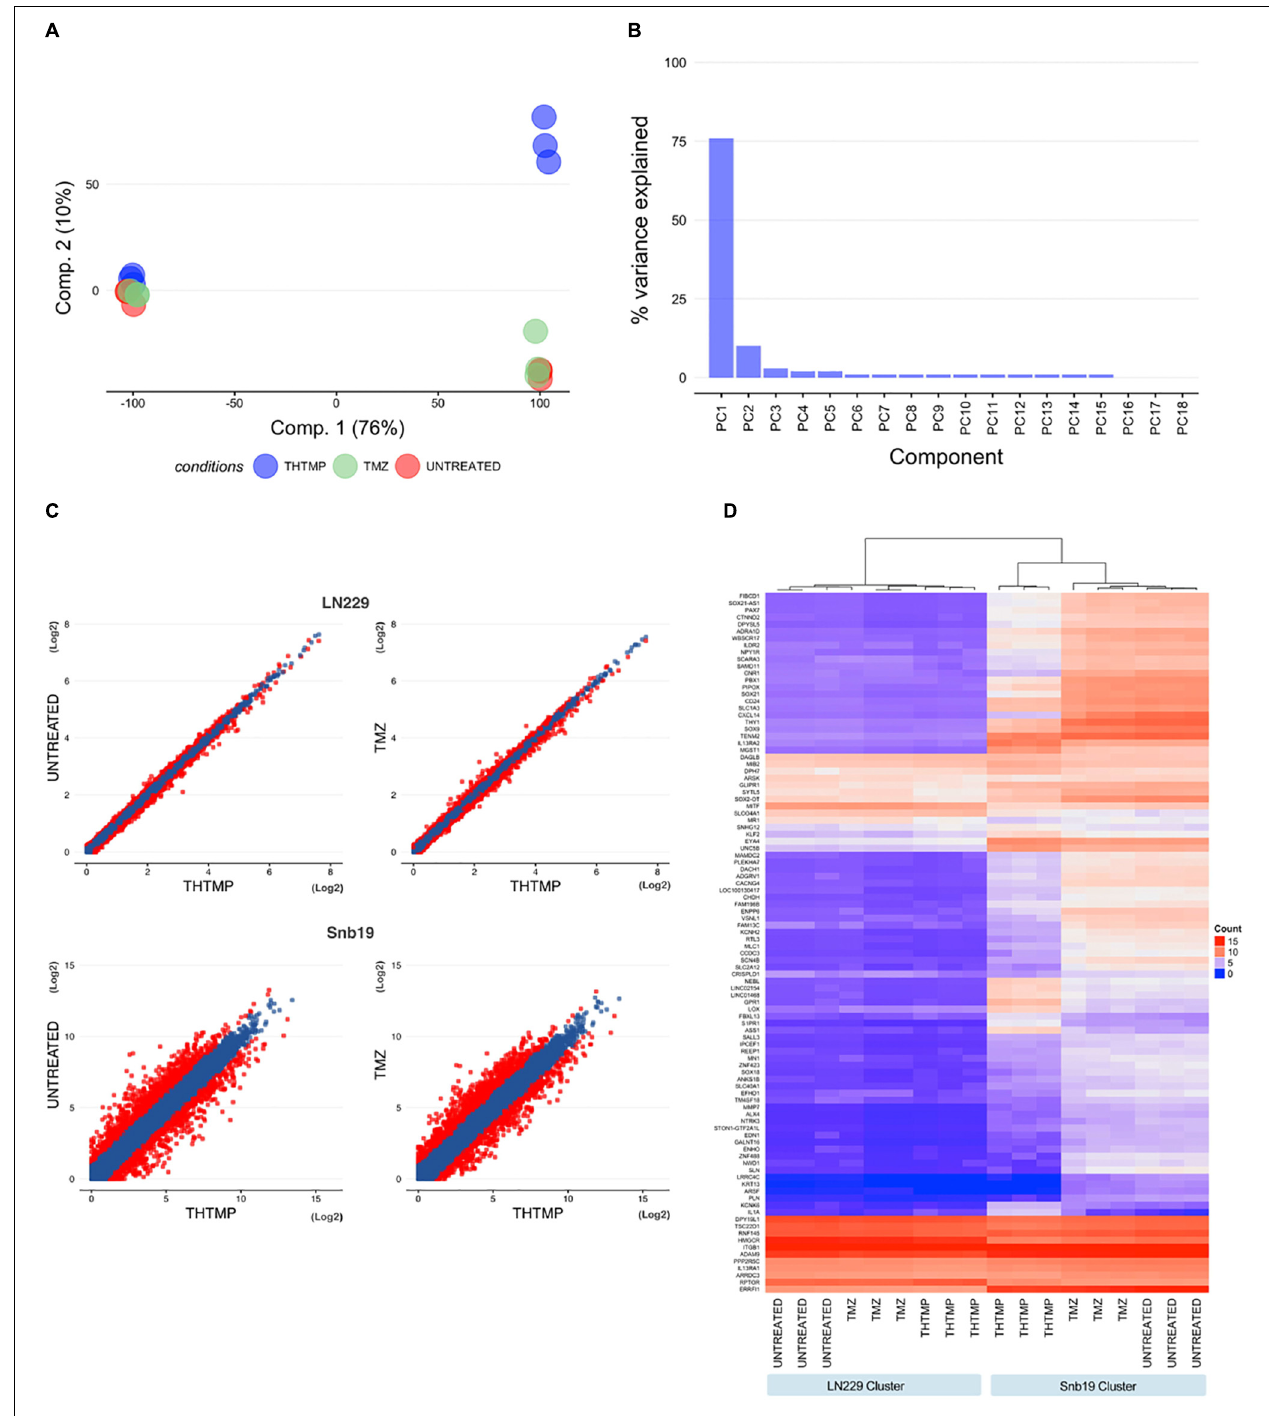
FIGURE 2 | Hierarchical clustering analysis, heatmap, and principal component analysis. (A) Principal component analysis (PCA) for all samples measured from LN229 and Snb19 cell lines. Principal component 1 (PC1) and principal component 2 (PC2) were identified by variance stabilizing transformation in DESeq2 on cell line samples. (Red, Untreated samples; Green, Temozolomide samples; Blue, THTMP samples). (B) The figure shows the percentage of variance that indicates how much variance was explained by PC1 and PC2. (C) Scatter plot analysis of gene expression using comparisons (THTMP vs. Untreated and THTMP vs. TMZ) in LN229 and Snb19 cell lines from the GMB. Genes whose expression levels changed by more than 1.5-fold after treatment are indicated in red. (D) Hierarchical clustering analysis and heatmap of the 100 genes with the smallest q-values in the time course analysis in DESeq2 (for Untreated, Temozolomide, and THTMP designate three replicate samples; negative, positive, and compound are individual cell lines in each